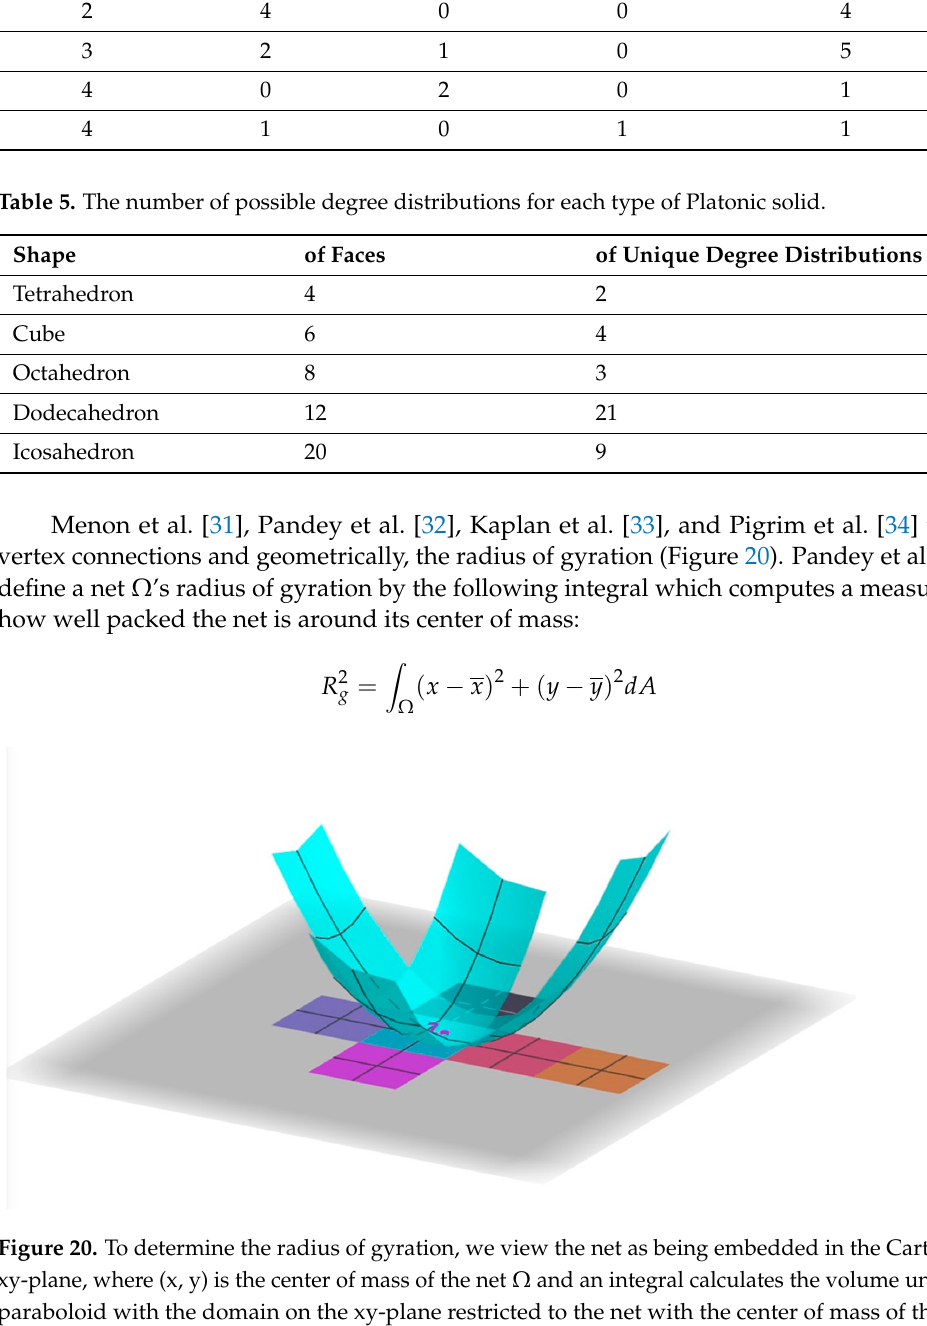
Table 4. The four satisfactory solutions to the pair of linear equations. A B C D Nets of This Type